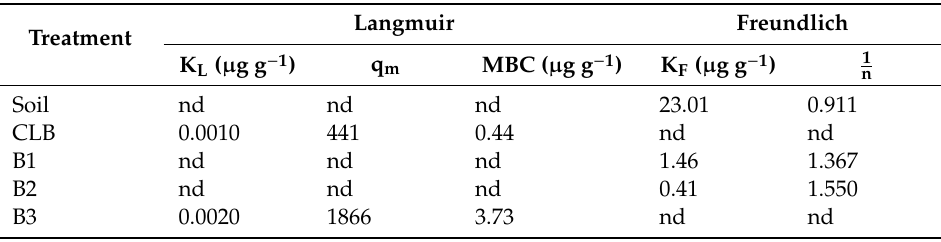
Table 19. Variables from Langmuir and Freundlich isotherms for potassium adsorption of di ff erent treatments.